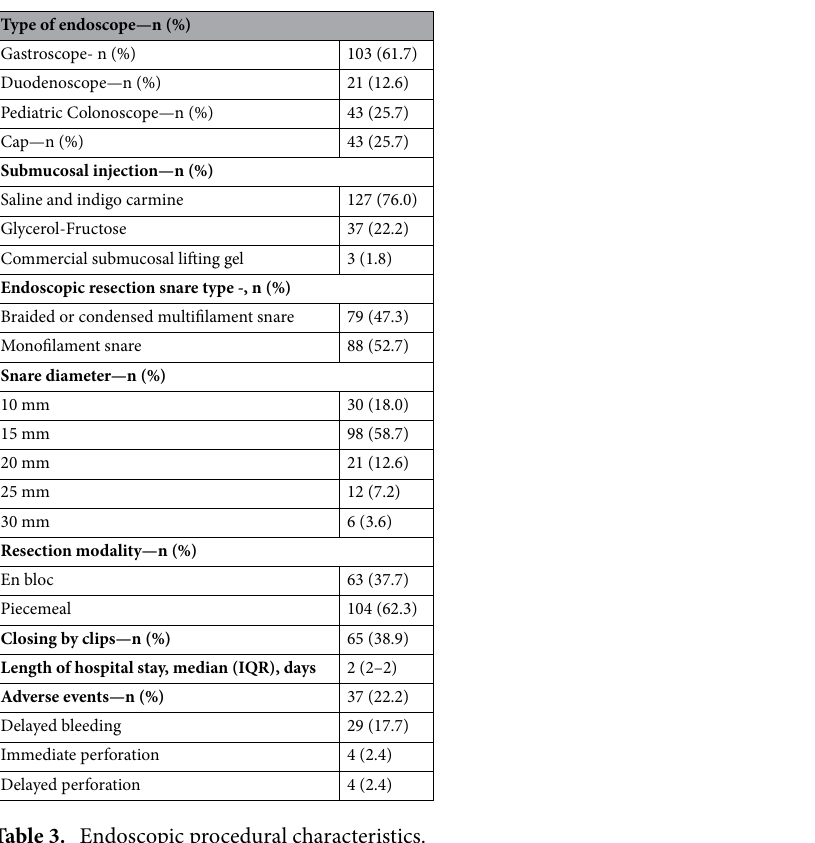
Table 3. Endoscopic procedural